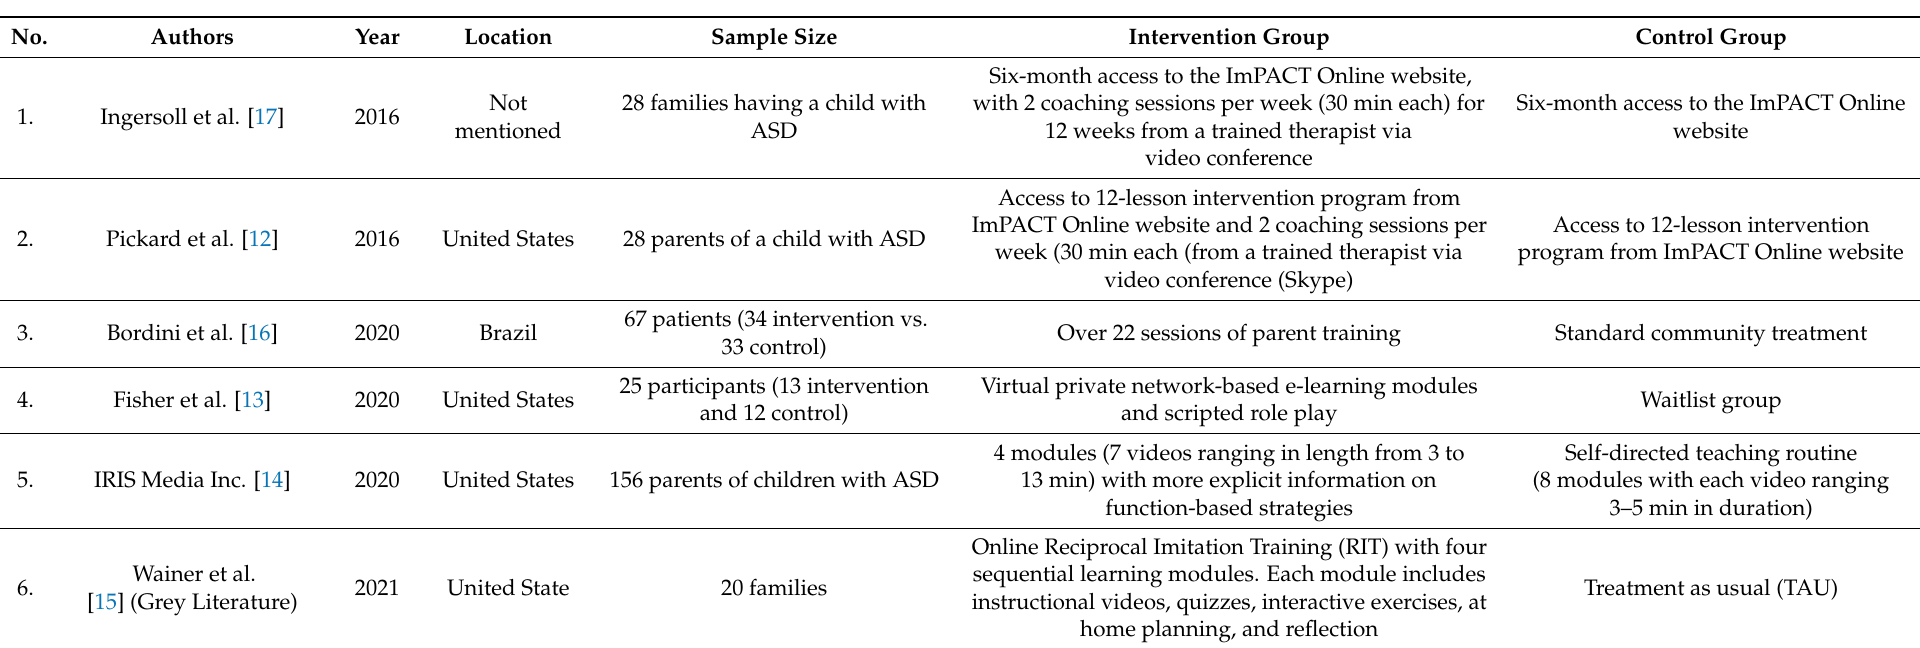
Table 1. Characteristics of the included